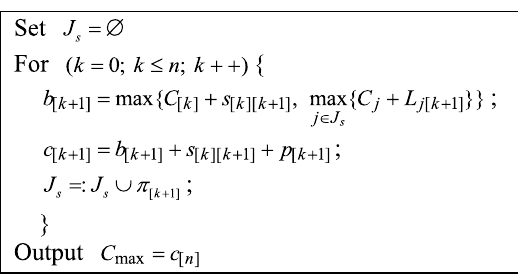
Figure 1. The procedure of the makespan calculation.